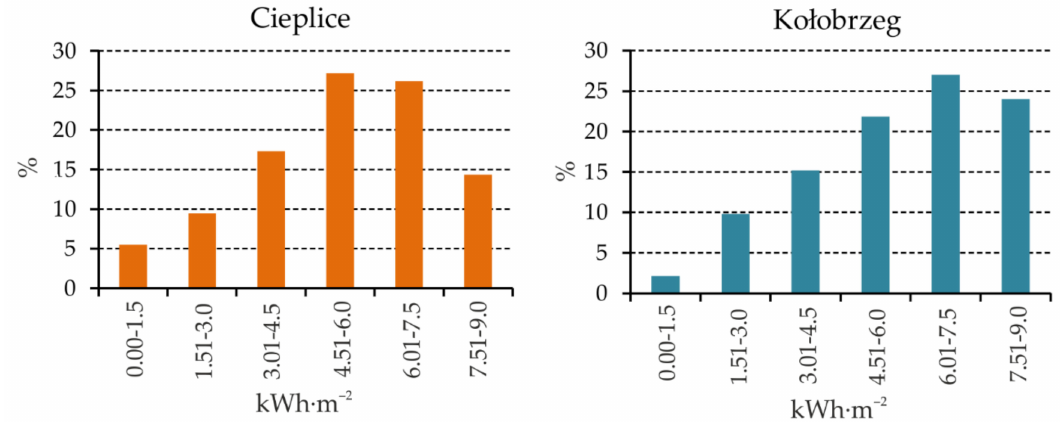
Figure 9. Histogram of daily sums of global solar radiation in June in Cieplice and Kołobrzeg. Data for the years 1996–2015.